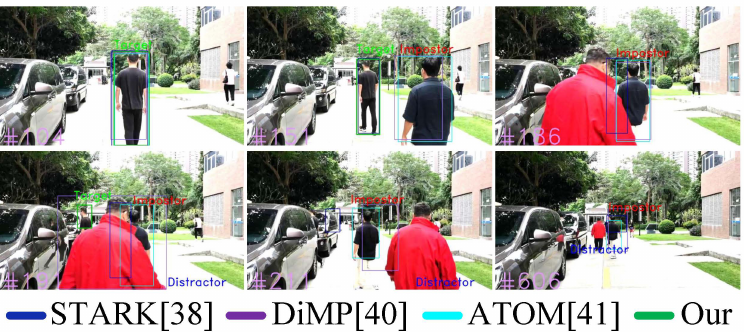
Figure 23. Person-Following Tests in Scenario#2 (seq#2), where the Target moves in varying illumi- nation environment, and is occluded with impostors and distractors, while, Target also moves out of